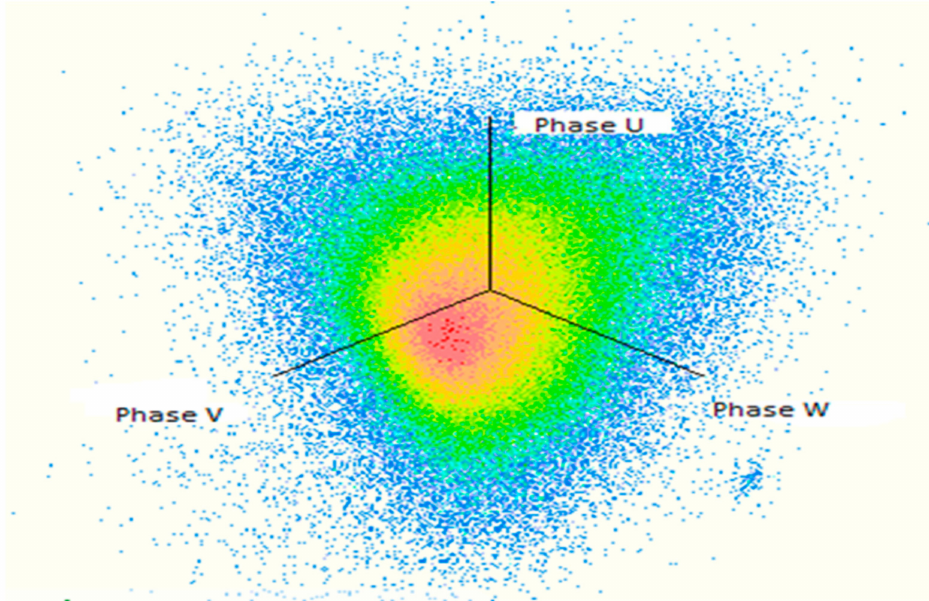
Figure 15. Different locations for PD with (3PARD) after oil